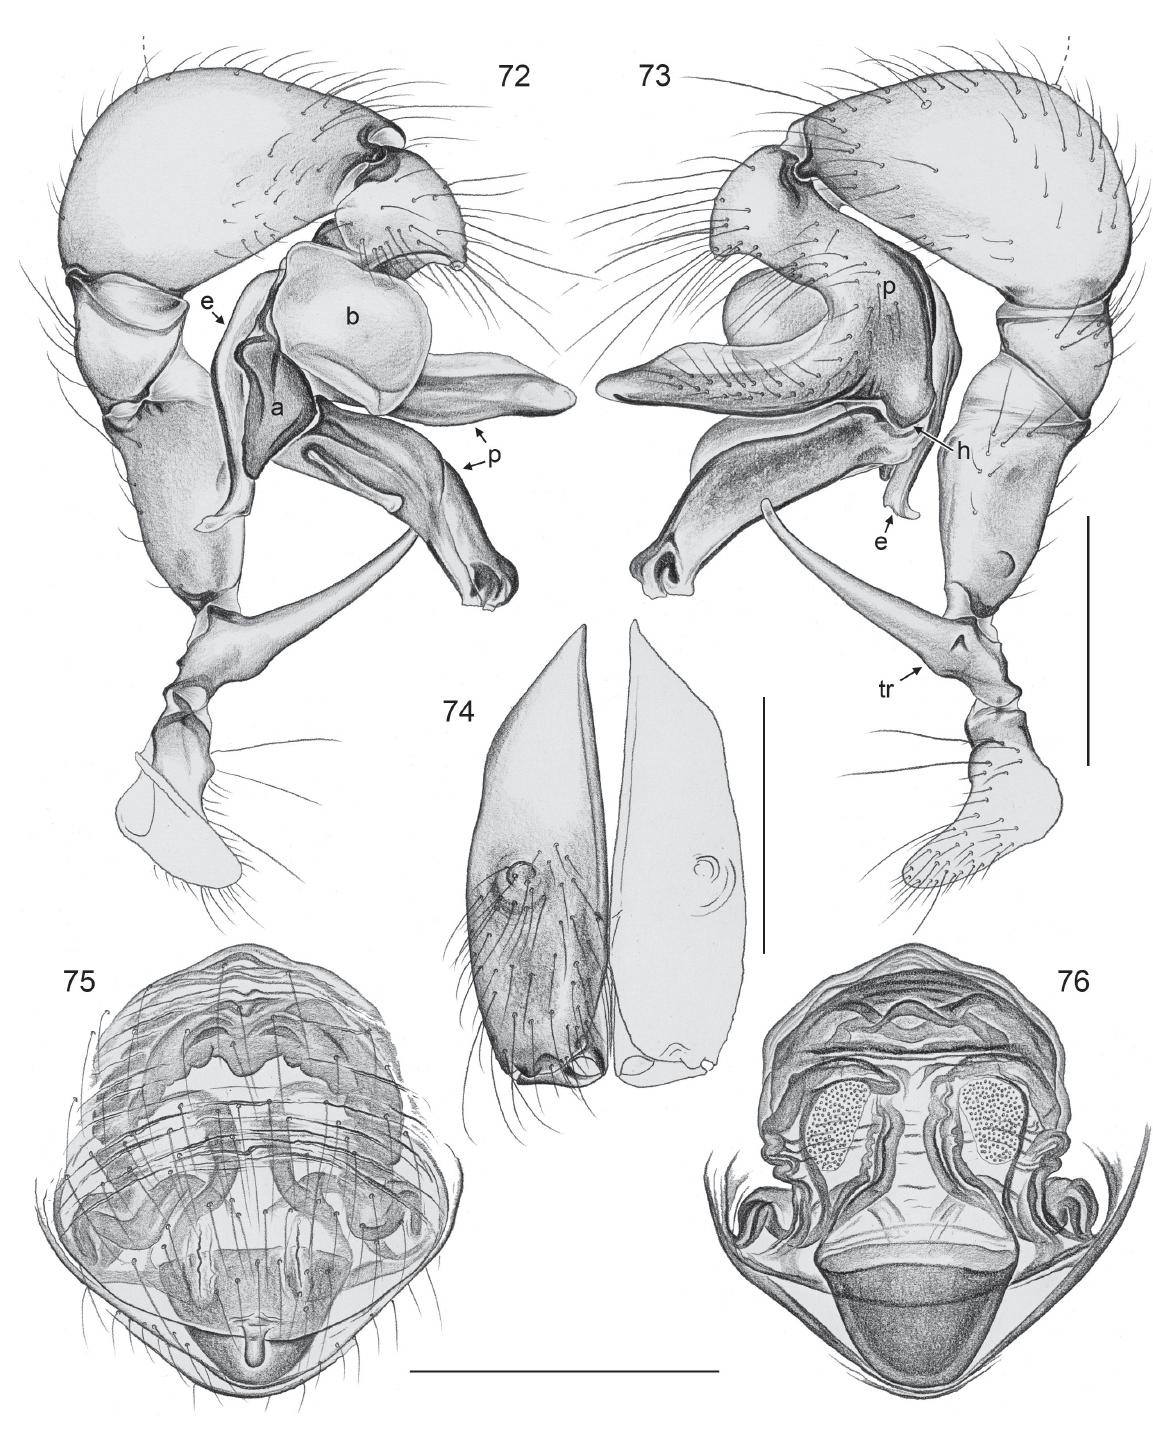
Figs 72–76. Pholcus barisan Huber sp. nov. (ZFMK, Ar 15708–09). 72–73 . Left male palp, prolateral and retrolateral views. 74 . Male chelicerae, frontal view. 75–76 . Cleared female genitalia, ventral and dorsal views. Scale bars: 72–73, 75–76 = 0.5 mm; 74 = 0.3